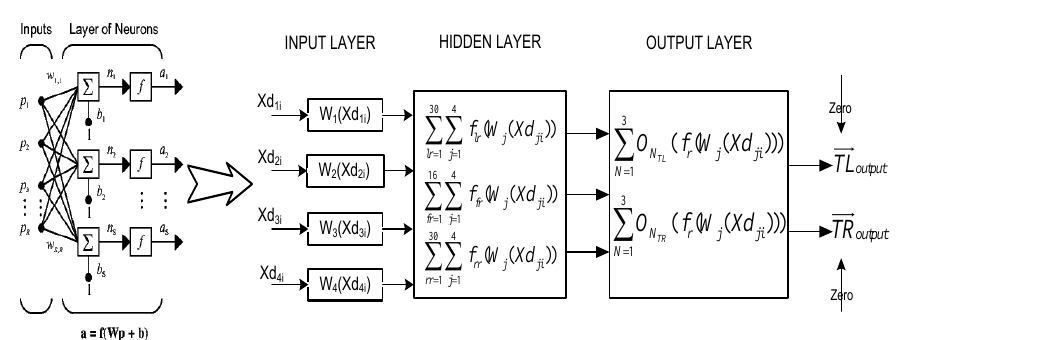
Fig. 12. Basic diagram of fuzzy neural approximation of proposed